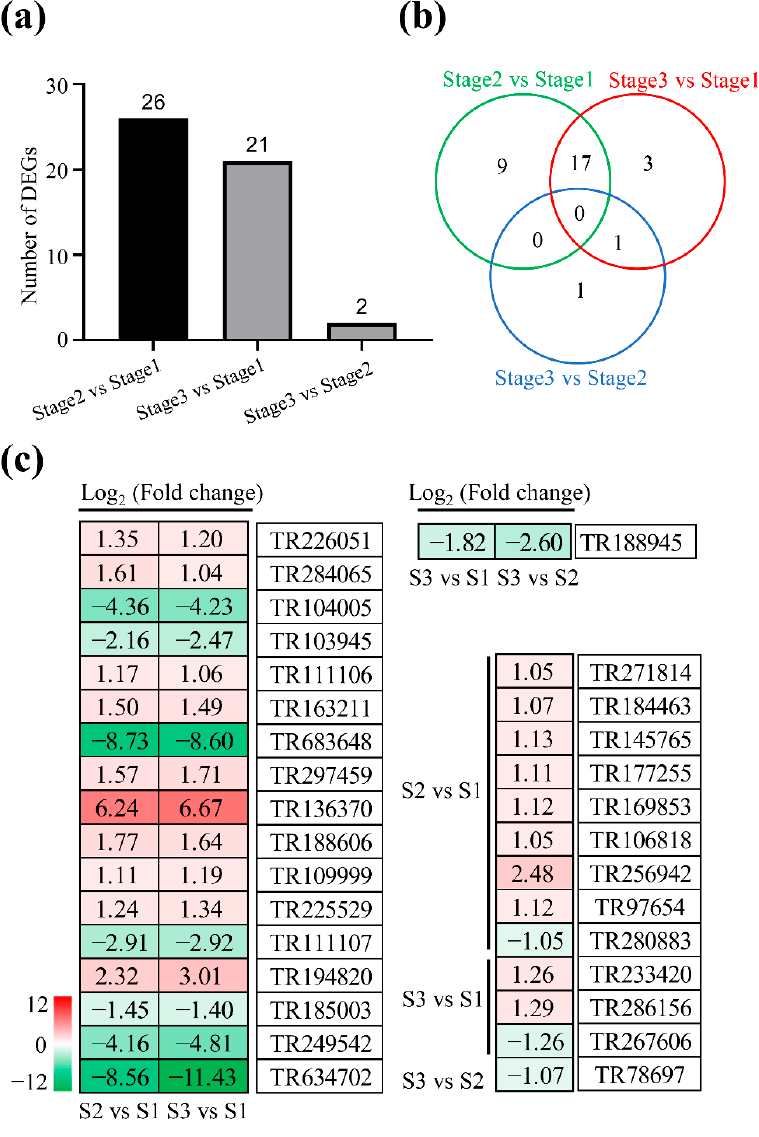
Figure 5. Analysis of differentially expressed genes involved in lipid metabolism. ( a , b ) Summary of differentially expressed genes at stage 1, stage 2, and stage 3. ( c ) The list of differentially expressed genes. Red and green represent up-regulated and down-regulated,